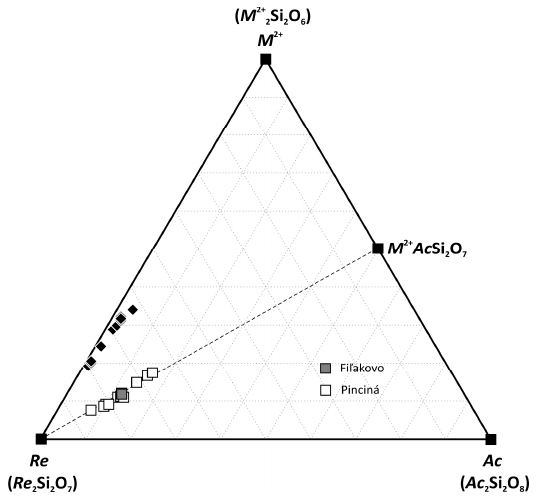
Figure 7. Molecular proportions in high- and low-Th yttrium silicates (open squares and black diamonds, respectively) recalculated from formulae based on seven oxygen atoms. Re and Ac refer to Y + REE and Th + U, respectively. M 2+ are large divalent cations (Fe, Ca, Mn, Mg). Data from Fi ľ akovo maar (shaded squares) are from [1].